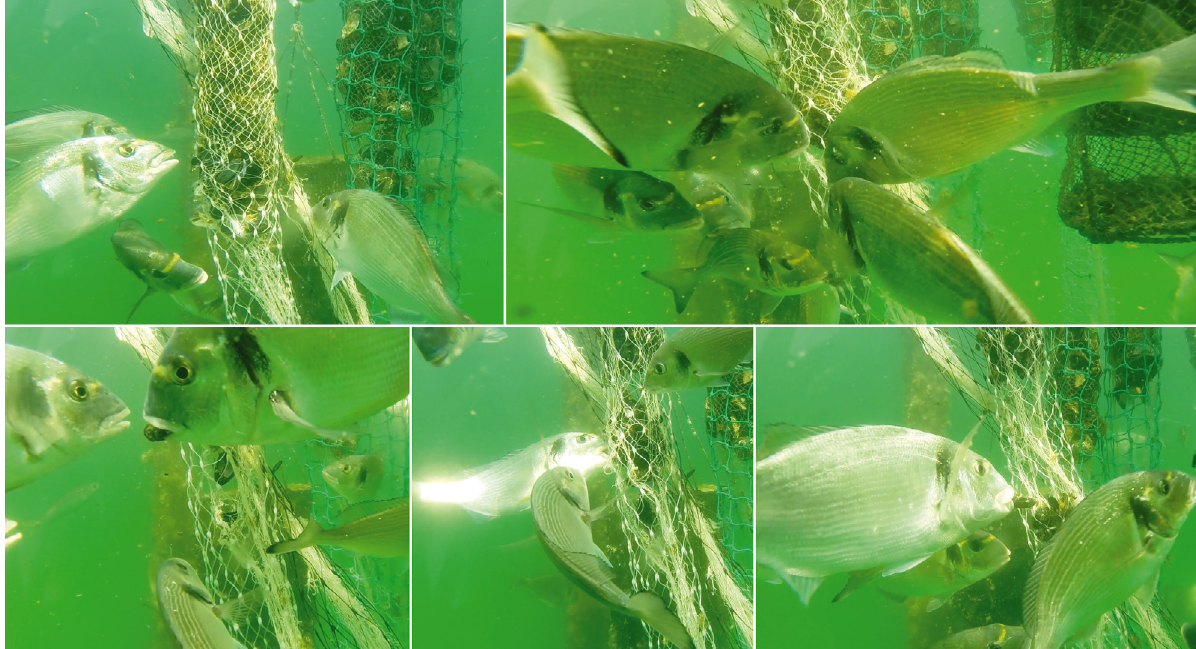
Fig. 1. Seabream Sparus aurata feeding on mussel ropes in Thau Lagoon, recorded with a GoPro Hero 4